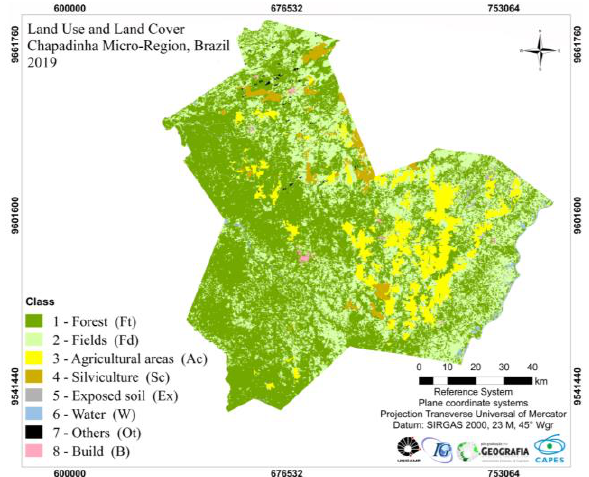
Figure 5. Land use and land cover map of the Chapadinha microregion (year: 2019).